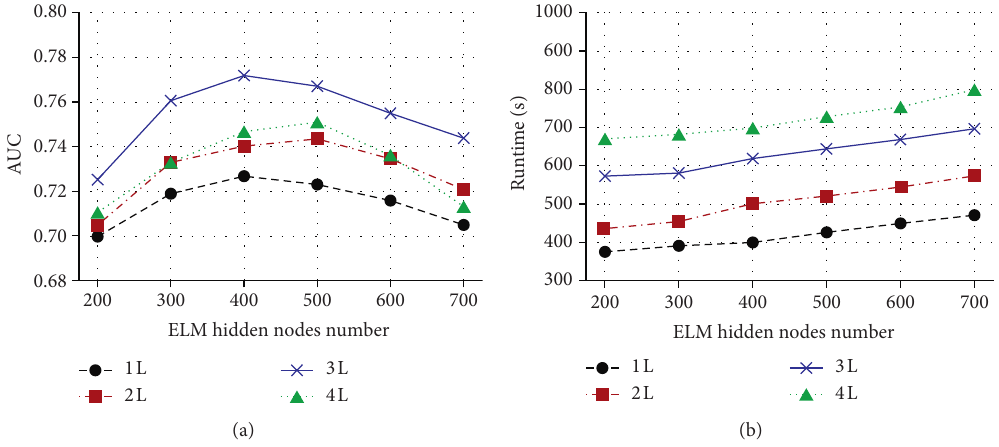
Figure 7: Performance evaluation of the ELM aggregator. (a) AUC. (b) Runtime.